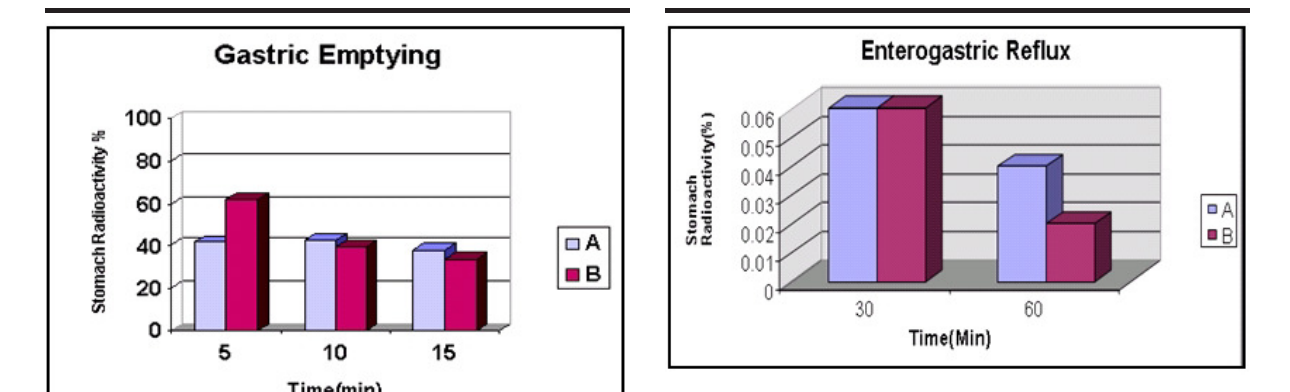
FIGURE 3 - Radioactivity emitted by the Stomach, at 30 and 60 min after the intravenous injection of Technetium 99m diisopropyl-iminodiacetic